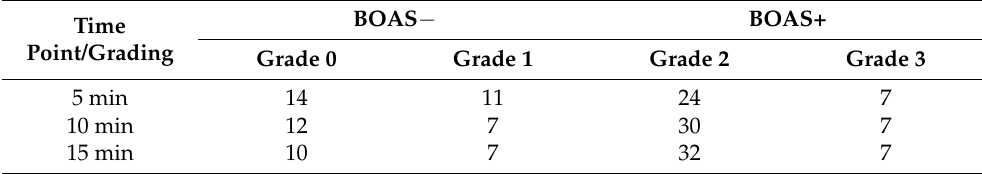
Table 3. Number of pugs ( n = 56) classified as grade 0, 1, 2, or 3 after 5, 10, and 15 min of exercise. Time